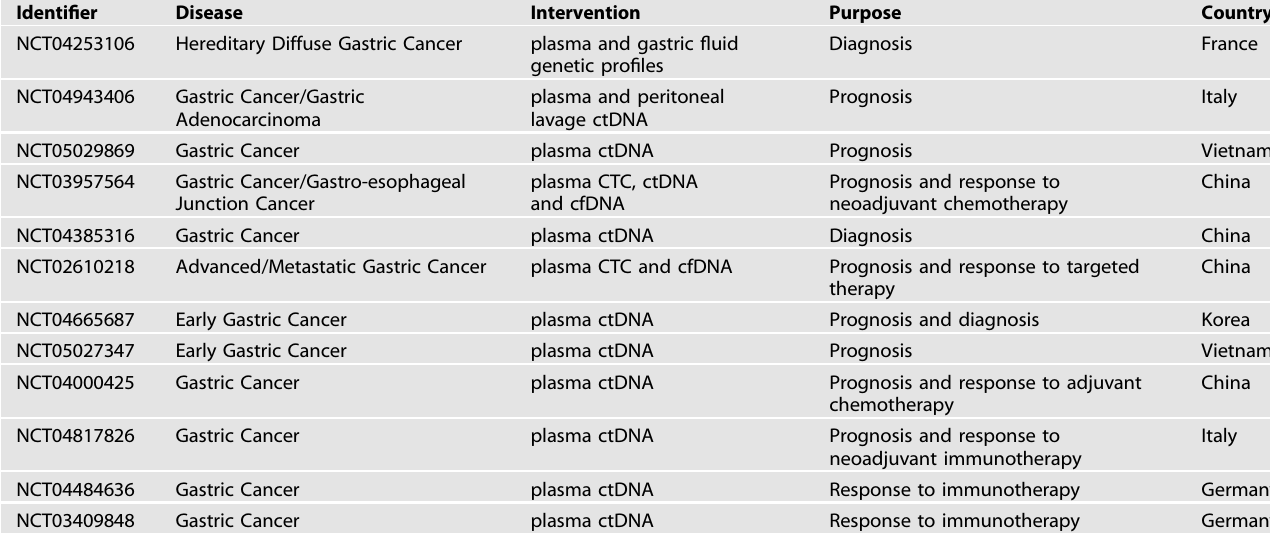
Table 4. Liquid biopsy in clinical trials of